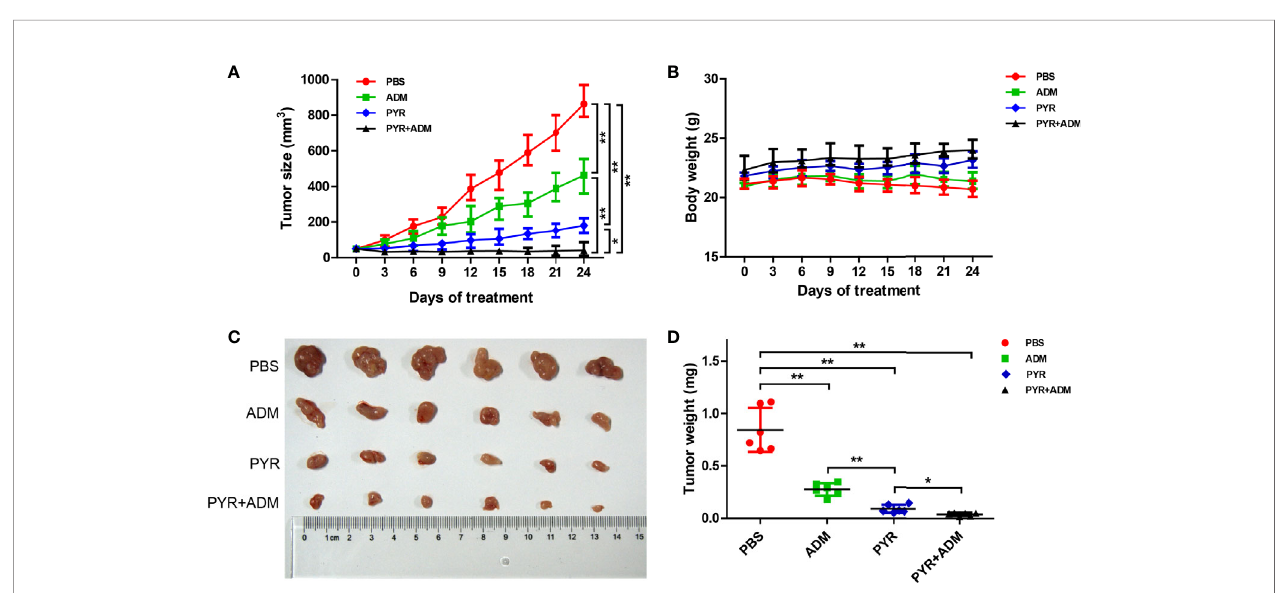
FIGURE 6 | In vivo anticancer effect of PYR and ADM in breast cancer xenograft models. Randomly grouped nude mice were treated with PBS, PYR(30 mg/kg), ADM(5 mg/kg), or a combination treatment (PYR+ADM) for 27 days. (A, B) Tumor growth ratio curve and body weight changes every three days after the onset of treatment. (C, D) Photos of the excised tumors and weight obtained on day 27 after treatment. *p<0.05 and